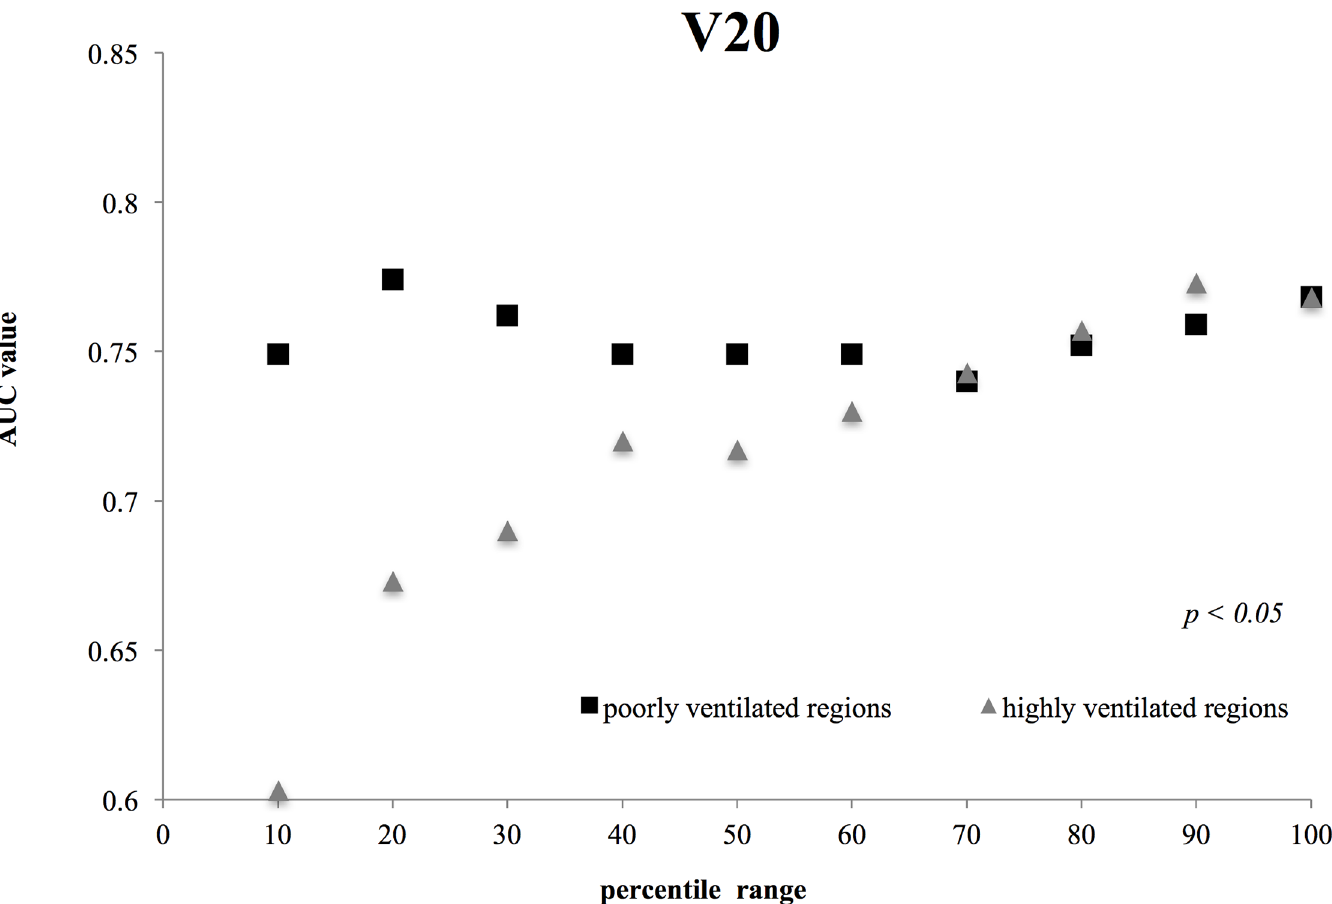
Fig 2. Comparisons between the V20 AUC values for highly and poorly ventilated regions. The difference in V 20 between poorly and highly ventilated regions was statically significant for each percentile range ( p = 0.0138; Student’s t -test).